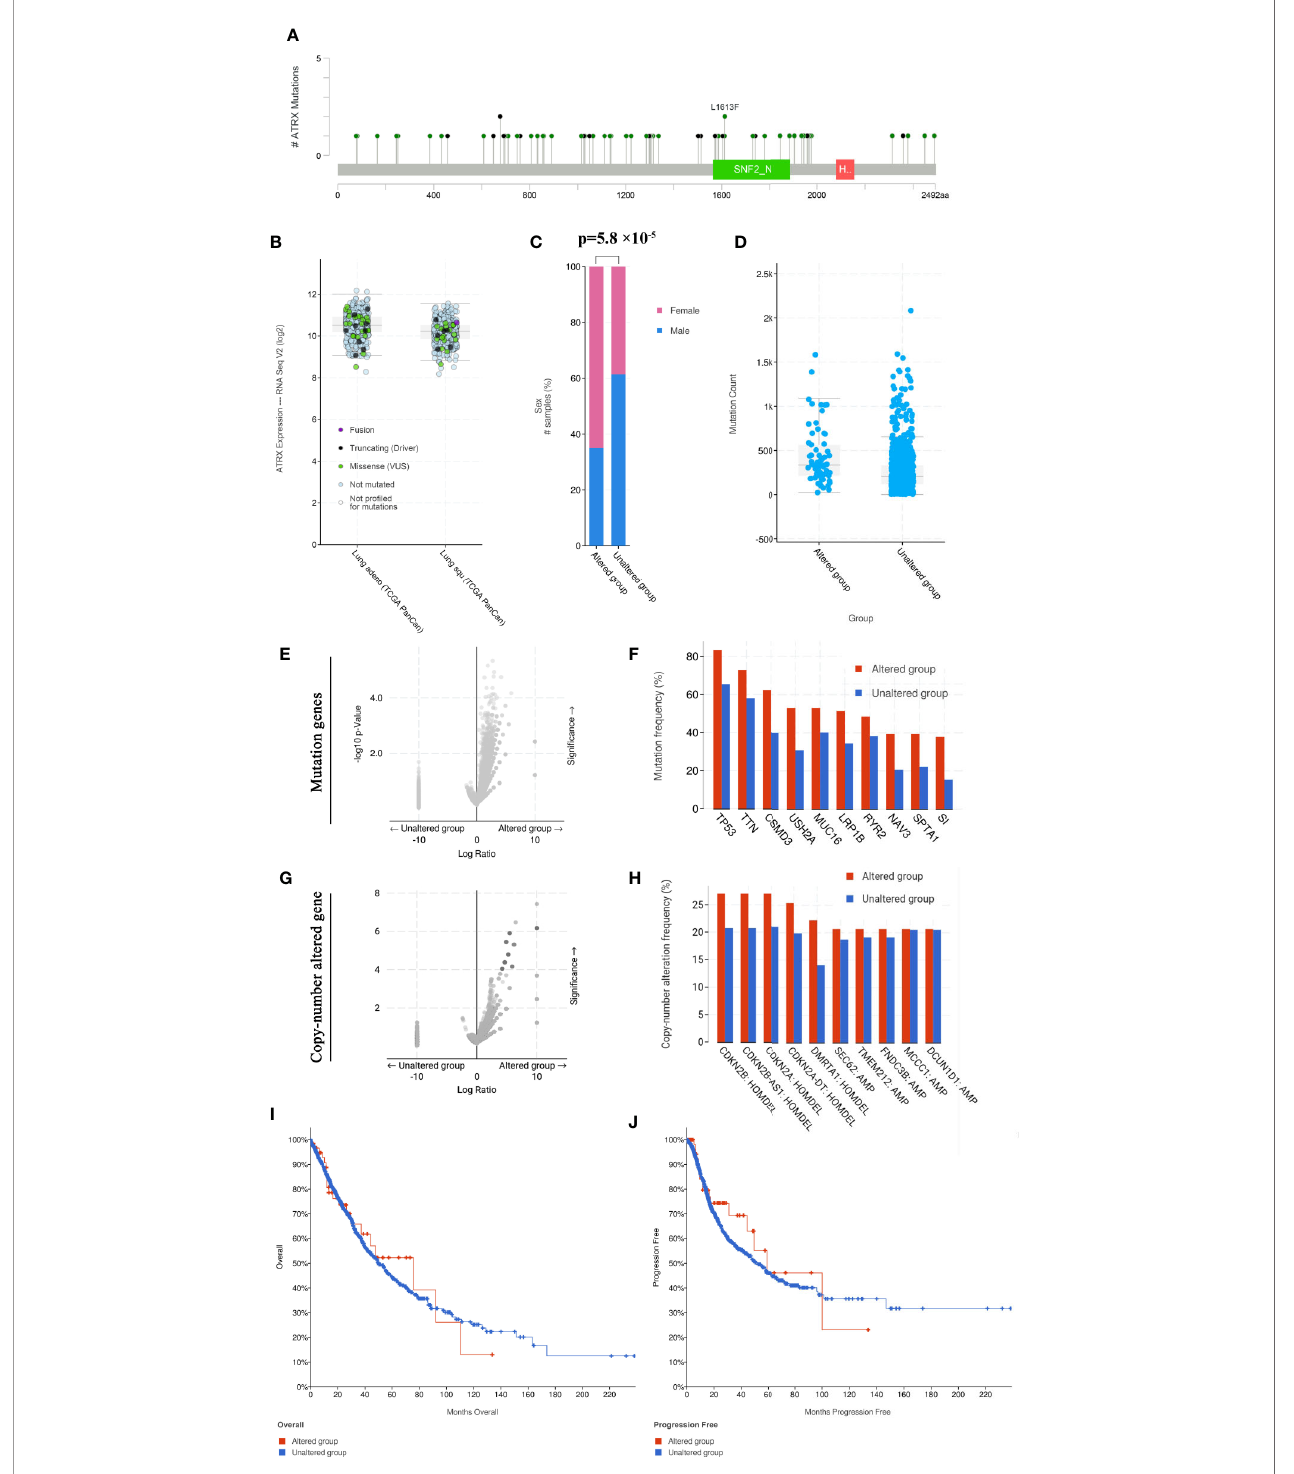
FIGURE 2 | Atrx mutation characteristics in NSCLC patients. (A) the mutation site of Atrx in NSCLC patients. (B) Different Atrx mutations forms in adenocarcinoma and squamous cell carcinoma. (C) Gender differences in patients with Atrx mutation. (D) The association between Atrx mutation and total mutation burden in NSCLC. (E) Comparison of tumor mutation genes between Atrx altered and unaltered patient groups. (F) the most frequently mutated gene accompanied with Atrx mutation. (G) Comparison of tumor copy-number altered genes between Atrx altered and unaltered patient groups. (H) the most frequent gene with altered copy number accompanied with Atrx mutation. (I) Differences in overall survival between Atrx altered and unaltered patients. (J) Differences in progression free survival between Atrx altered and unaltered